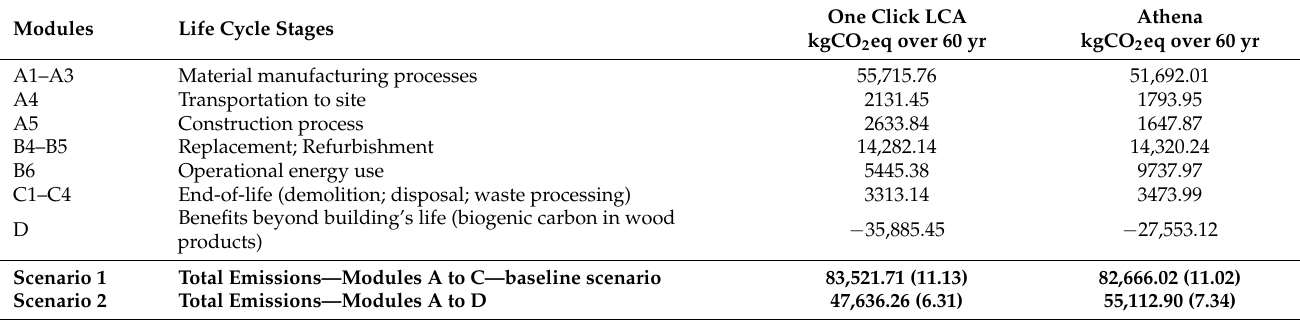
Table 7. LCA results for Future Buildings Laboratory: Global warming potential (without contribu- tion of trees).